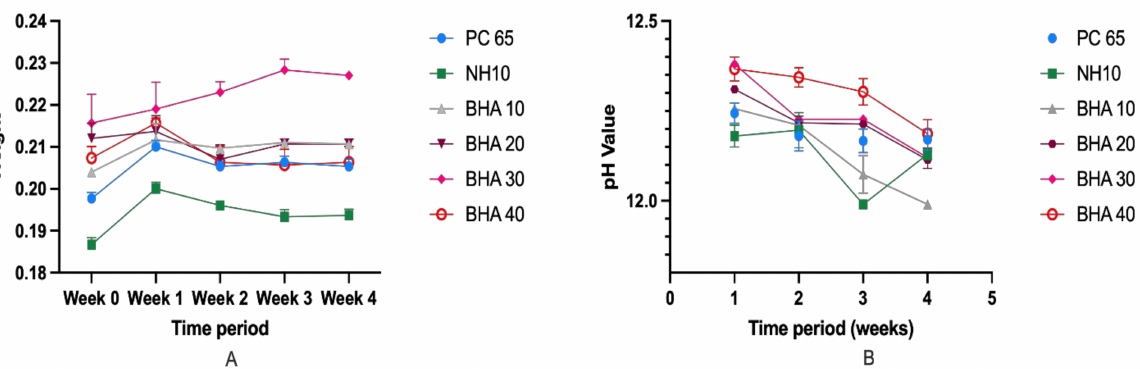
Figure 6. ( A ) Average pH value of the tested cements for the duration of 4 weeks. ( B ) Mean weight loss of the materials studied over the four-week period. (n =